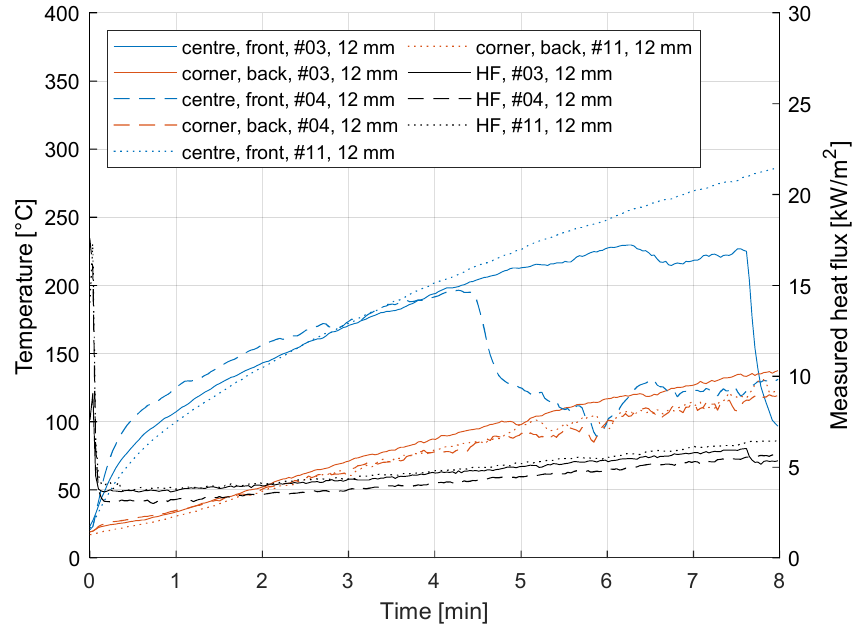
Figure 6. Temperature development and measured heat flux for 12 mm thick specimens (Test #3, #4 and #11). Note that #1 and #2 are not plotted in this graph because in those tests the TCs were attached to the centre only. Additionally note that the centre front TC (TC1) in test #3 and #4 loosened from the surface at 6.5 and 4.5 min, respectively.